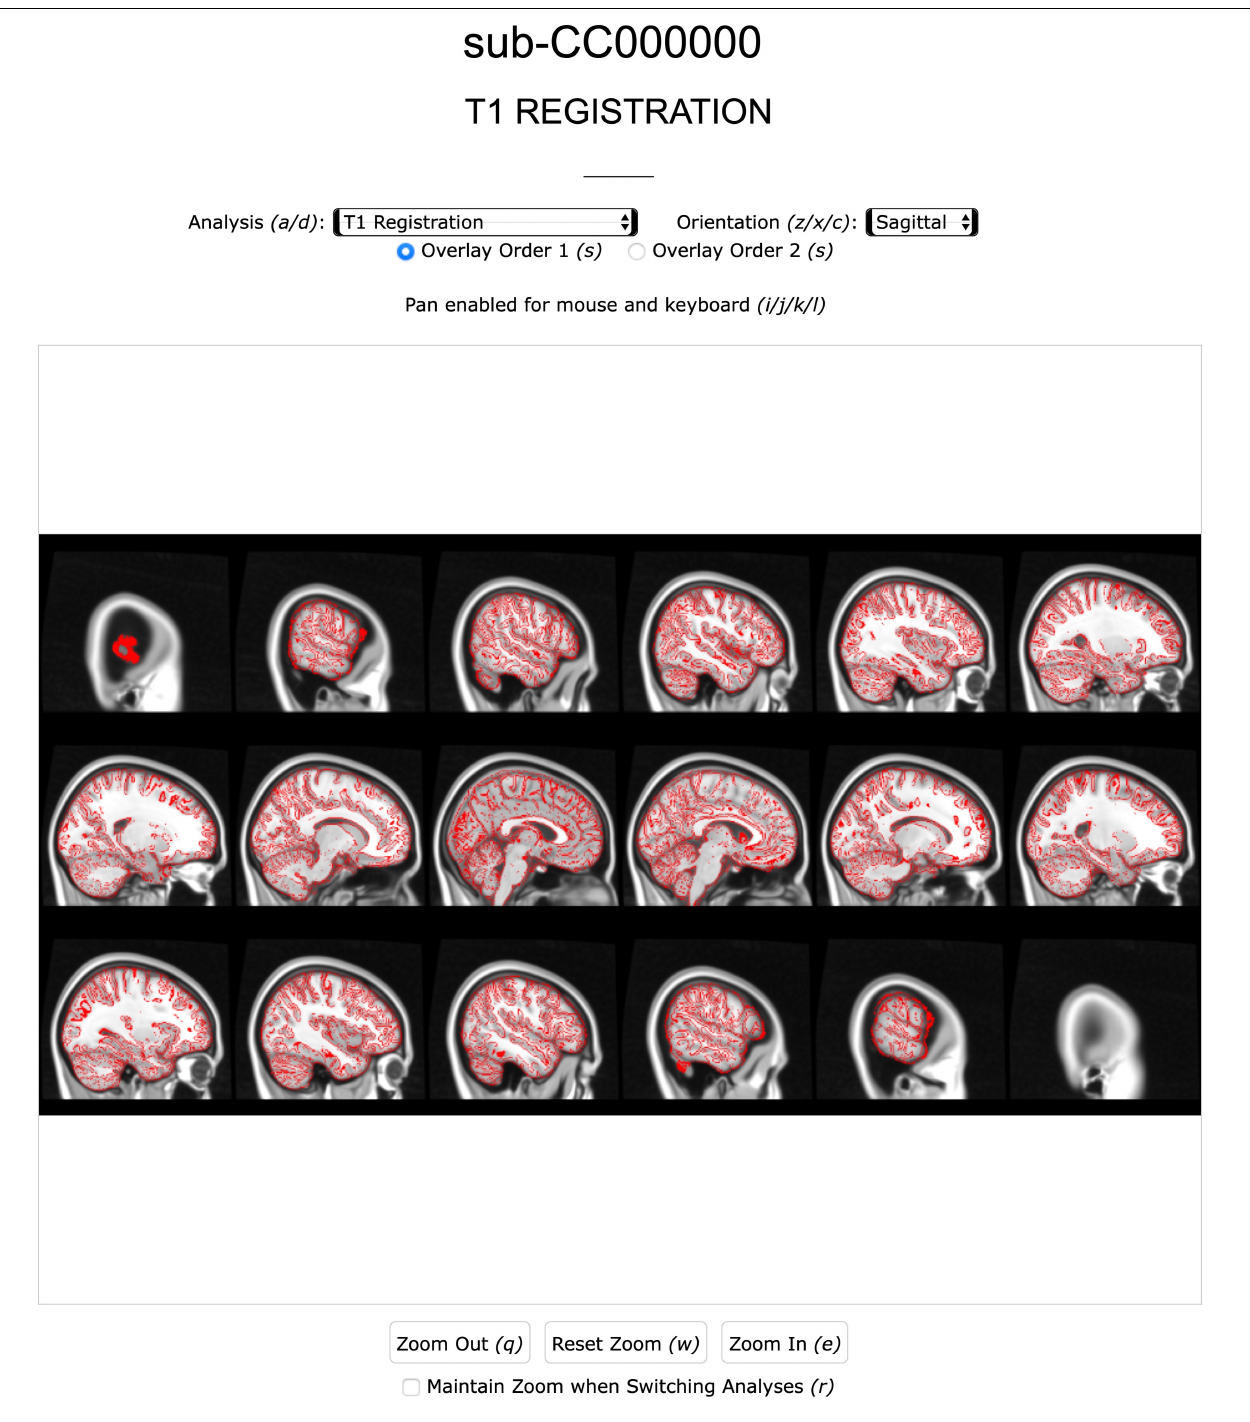
FIGURE 5 | Screenshot of the Anatomical page of a subject’s QC report. Analysis [e.g., extraction, registration (shown), segmentation] and image view can be navigated with mouse or keyboard.